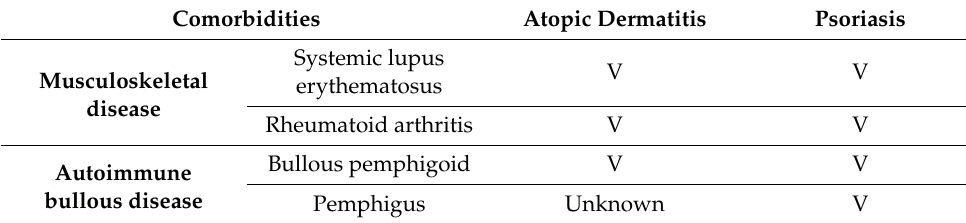
Table 1. Cont. Comorbidities Atopic Dermatitis Psoriasis Systemic lupus V V Musculoskeletal erythematosus disease Rheumatoid arthritis V V Bullous pemphigoid V V Autoimmune bullous disease Pemphigus Unknown